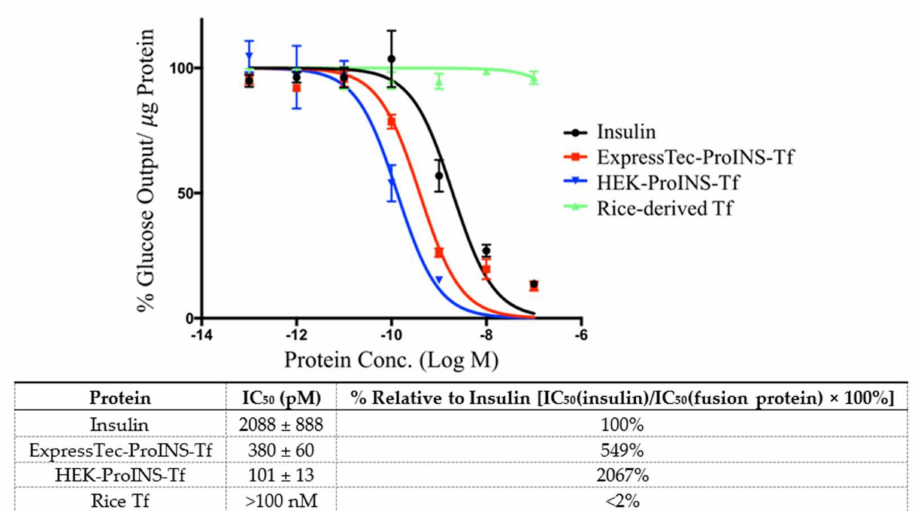
Figure 5. Glucose production inhibition in H4IIE cells and calculated IC 50 . H4IIE cells were treated with insulin, ExpressTec-ProINS-Tf, HEK-ProINS-Tf or rice-derived Tf with various concentrations from 0.1 to 100 nM at 37 ◦ C for 24 h, and then incubated with glucose production medium for an additional 3 h. Glucose concentration of each sample was measured using the Amplex Red Glucose/Glucose Oxidase Kit. The result was expressed as percentage of total glucose output in the absence of any protein ( n = 3). All data were normalized with total cell protein amounts. The indicated IC 50 values (mean ± SD) were calculated using GraphPad Prism (GraphPad Software Inc., San Diego, CA,